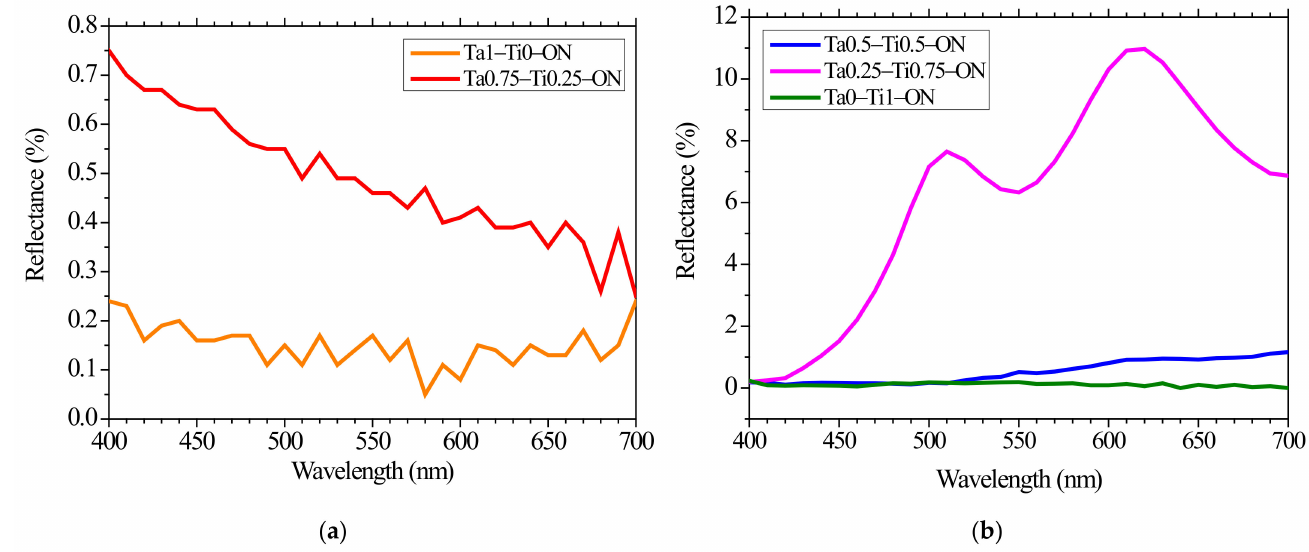
Figure 12. The variation of the reflectance as a function of the wavelength of the incident radiation: ( a ) Ta1–Ti0–ON and Ta0.75–Ti0.25–ON; ( b ) Ta0.50–Ti0.50–ON, Ta0.25–Ti0.75–ON and Ta0–Ti1–ON. The reflectance spectra of Ta1–Ti0–ON and Ta0.75–Ti0.25–ON samples (Figure 12a) are low (dark films). The reflectance of the Ta0.25–Ti0.75–ON film is typical of a transparent material, exhibiting interference fringes coherent with its thickness (Table 1). The Ta0–Ti1– ON sample (TiON film) seems to be too thin to exhibit the interference fringes, and the film produced with the same current applied to both targets (Ta050–Ti0.50–ON) is probably